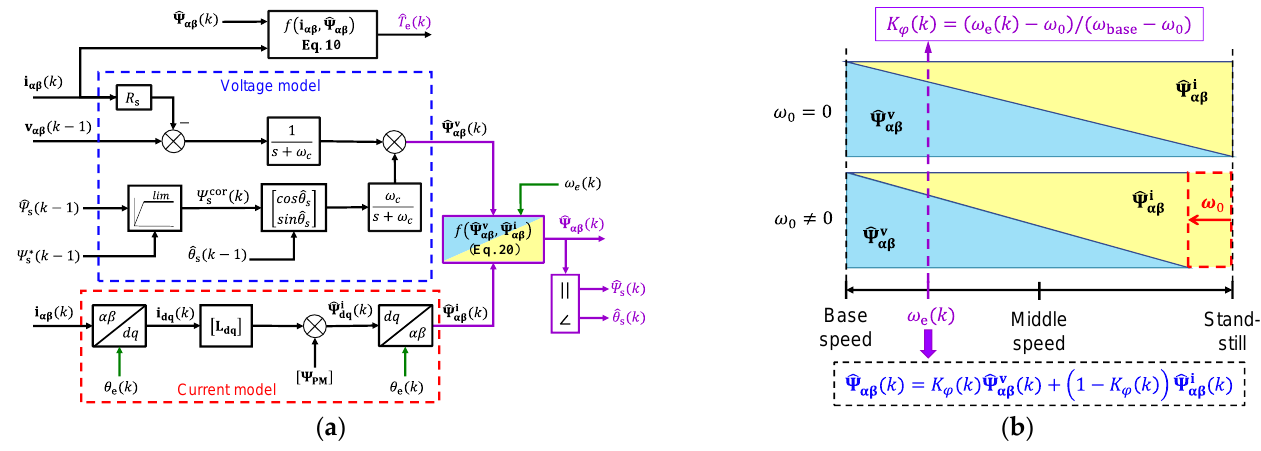
Figure 4. ( a ) Modified hybrid flux linkage observer scheme and ( b ) a proposed hybrid strategy for flux linkage calculation.